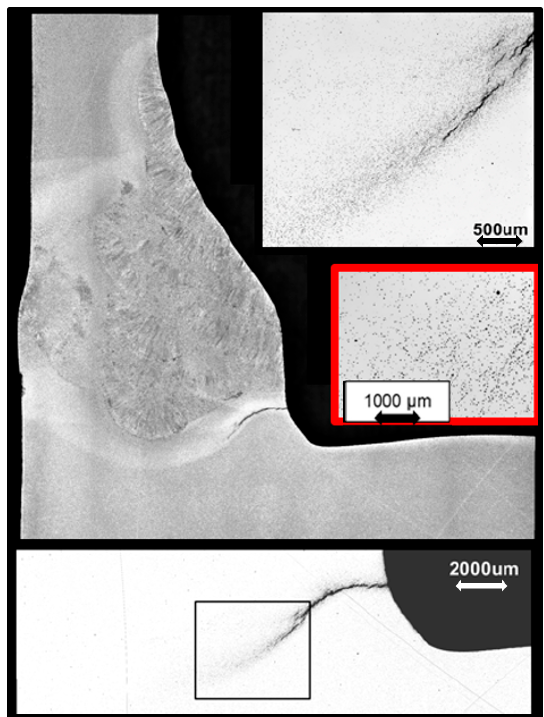
Figure 1. Micrographs showing detail of cracking at a stub tube to header weld. Cracking found at this location at an earlier inspection had been removed by local grinding. It is noteworthy that the re-cracking event did not take place at the base of the excavation. Instead, the creep damage is focused on the metallurgically susceptible structures in the weld